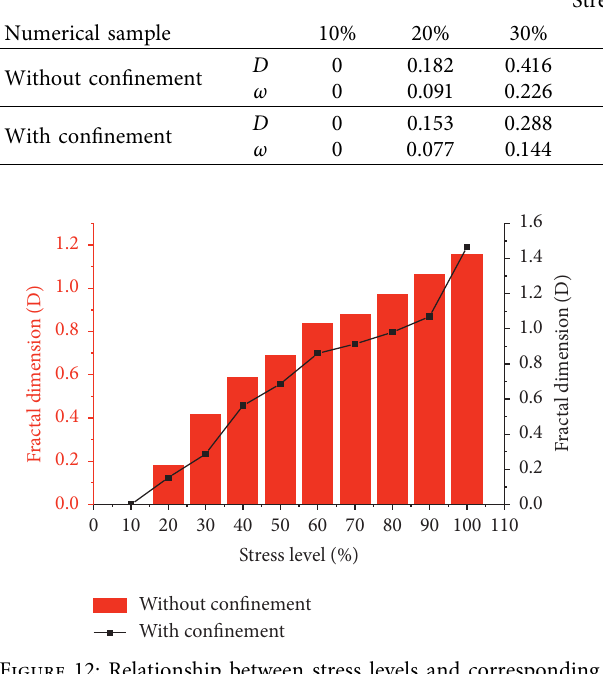
Figure 12: Relationship between stress levels and corresponding fractal dimensions.